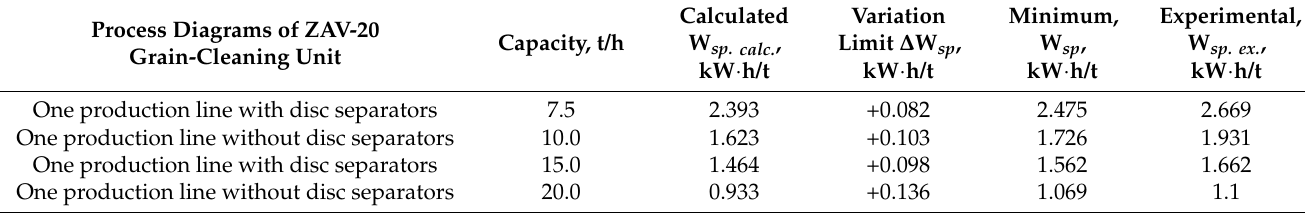
Table 3. Comparative data of electricity consumption rates for grain cleaning on the production lines of ZAV-20 grain-cleaning